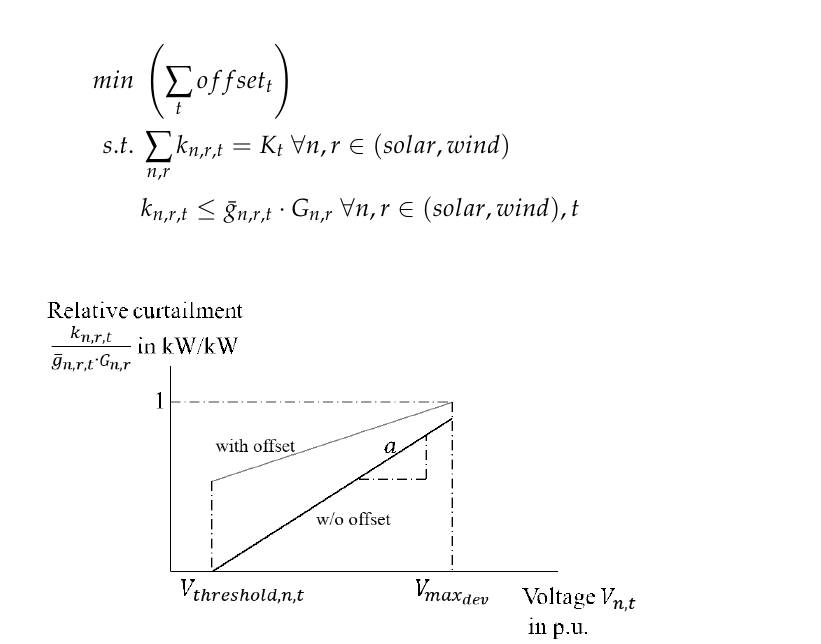
Figure 8. Linear relation between relative curtailment and bus voltage used to allocate curtailment